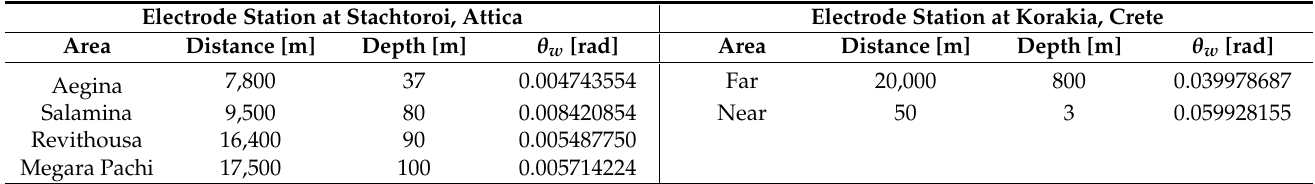
Table 1. Geometric characteristics (distances, depths and angles of seabed) of electrode